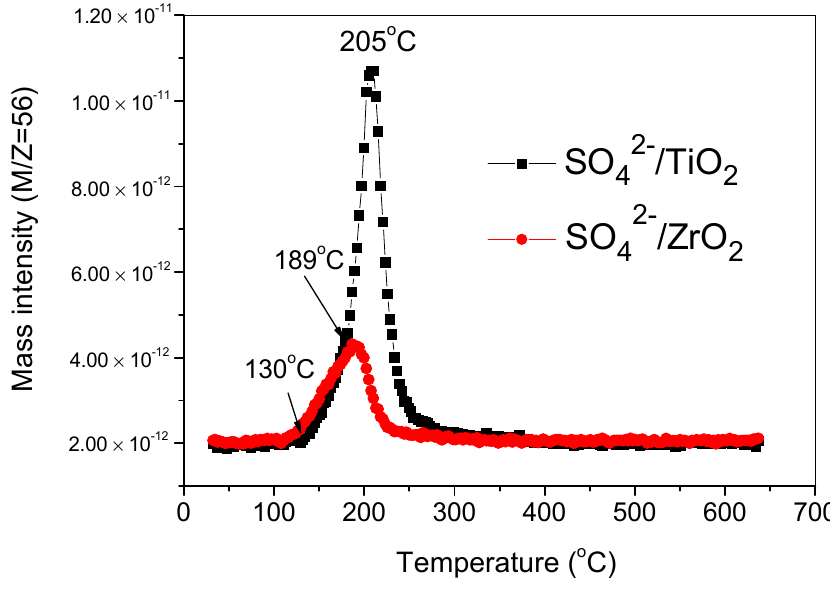
Figure 6. Acrolein in the TPSR of super acid.